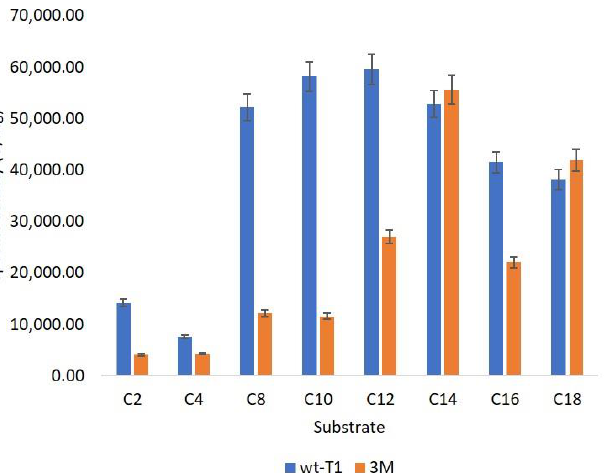
Figure 3. Substrate specificity of wt-T1 and 3M lipases toward different pNP-ester carbon lengths. 2.4. Hydrolysis of Palm Stearin by wt-T1 and 3M lipases